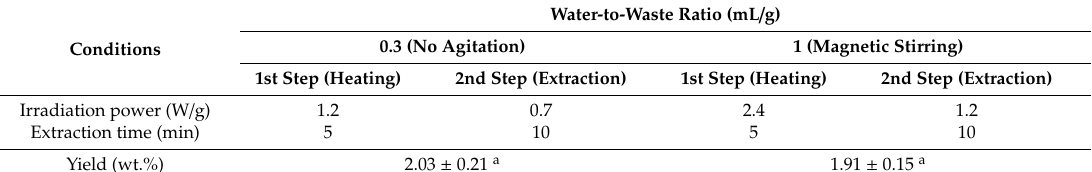
Table 1. Extraction conditions and obtained yield for lemon essential oil (LEO) from lemon waste by microwave-assisted hydrodistillation (MAHD). Mean ± Standard Deviation (SD), n = 3. Di ff erent superscripts in yield values indicate statistically significant di ff erent values ( p <